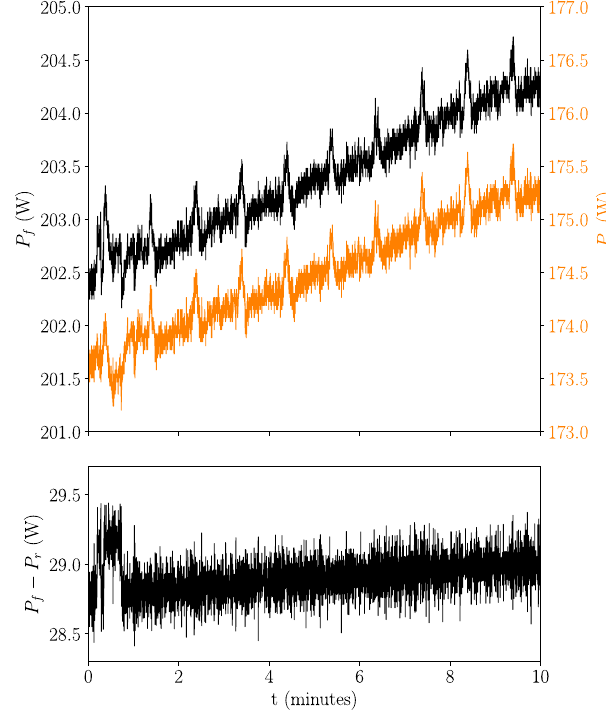
FIG. 7. Example of raw data of measured forward power P and f reverse power P (top) of the first main accelerator cavity r (A1SC01, see Fig. 2). The power values increase slightly over time because of heating of the input coupler due to rf losses at the coupler during the first hours of operation. The slope of the increasing powers is nearly the same recognizable in the bottom plot which shows just a small relative slope of 10 − 4 1 = s in the difference of both powers over